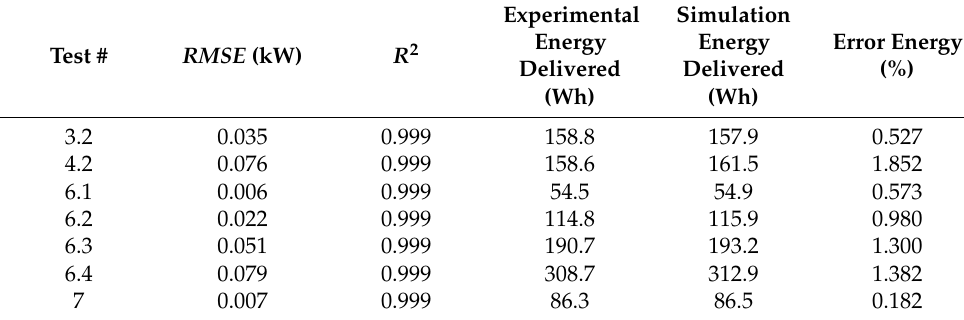
Table 8. Battery Testing Power and Energy